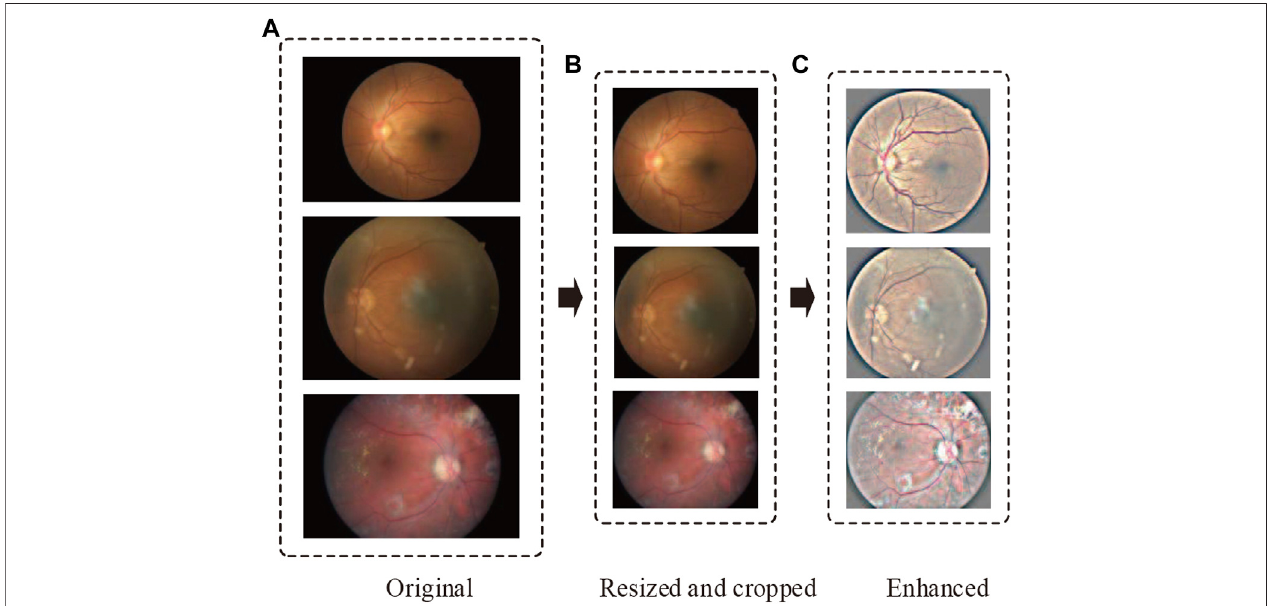
FIGURE 2 | Representative retinal images adopting our preprocessing techniques. From top to bottom, the representative images are sampled from no DR, moderate DR, and proliferative DR, respectively. The parts (A – C) denote the original, resized and cropped, and enhanced retinal images.